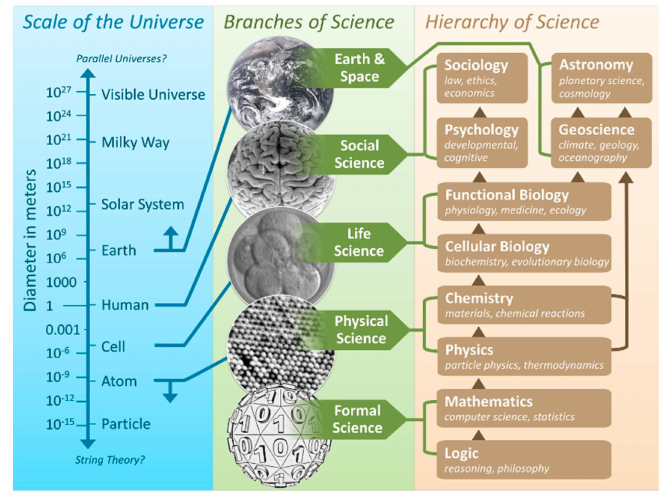
Figure 7. Branches of science and the hierarchy of science, mapped to the scale of the universe (from [35]).